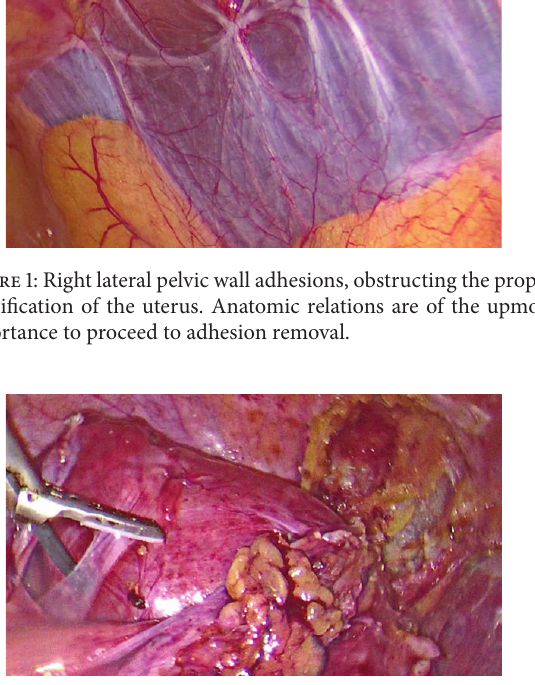
Figure 2: Bicornual uterus with dense adhesions to colon and various bowel segments. Proper resection of these adhesions had to be performed in order to have a clear view of the uterus and proceed to